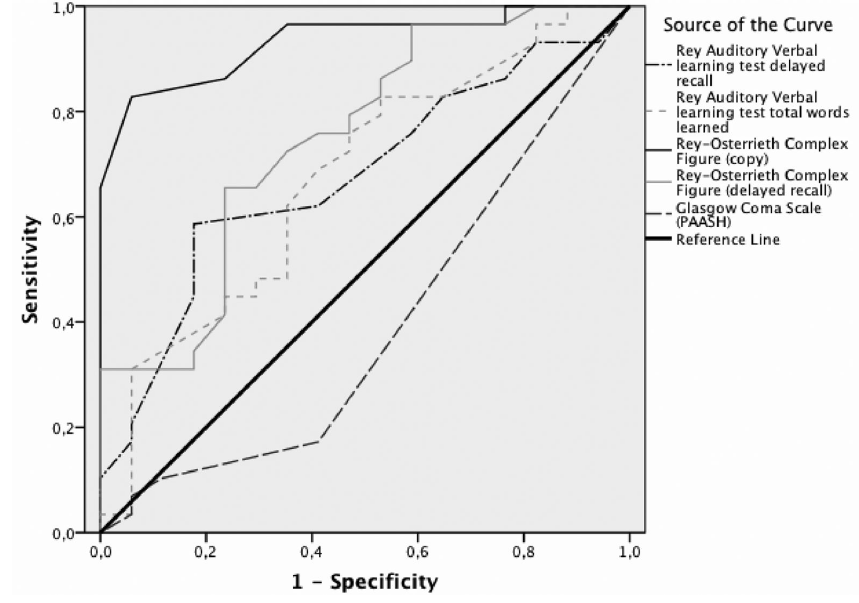
Fig. 1. ROC curve. Prognostic validity of neuropsychological tasks on cognitive functioning in the long